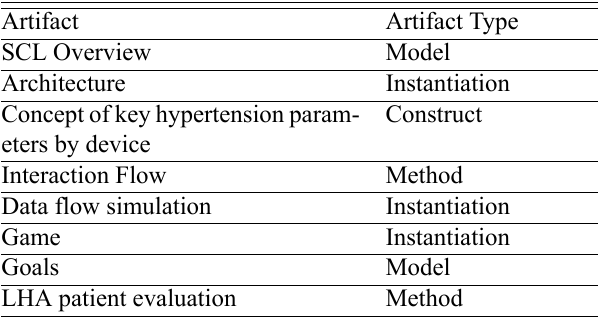
Table 2. Generated